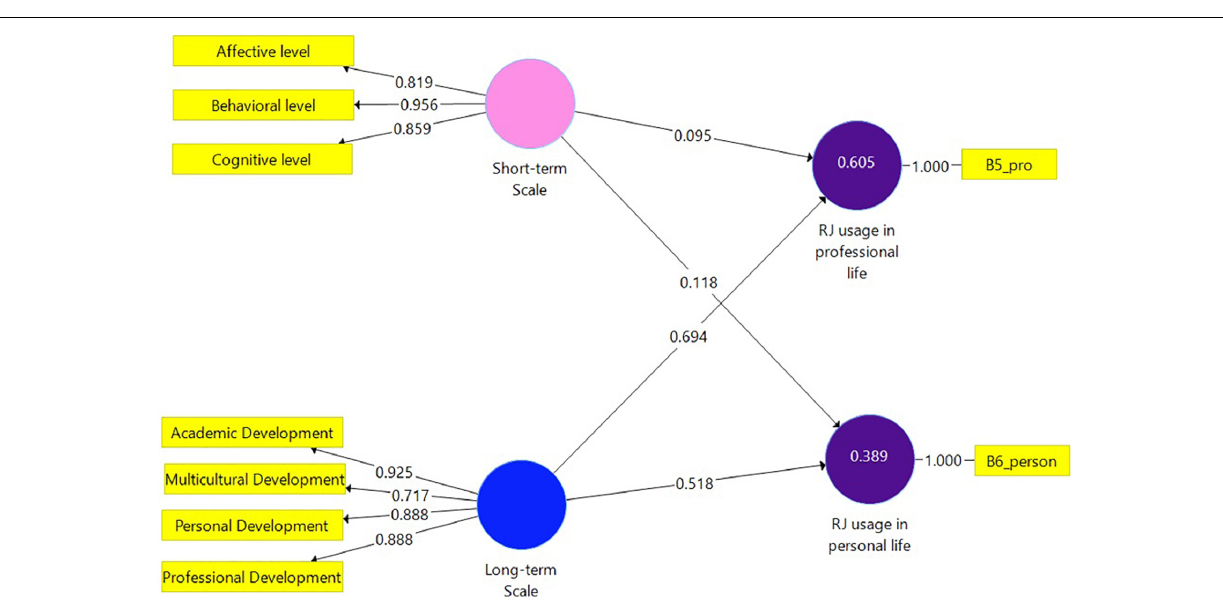
FIGURE 4 | Model 4. Analysis results of the examination of the research hypotheses by SmartPLS (Health Management sample N =